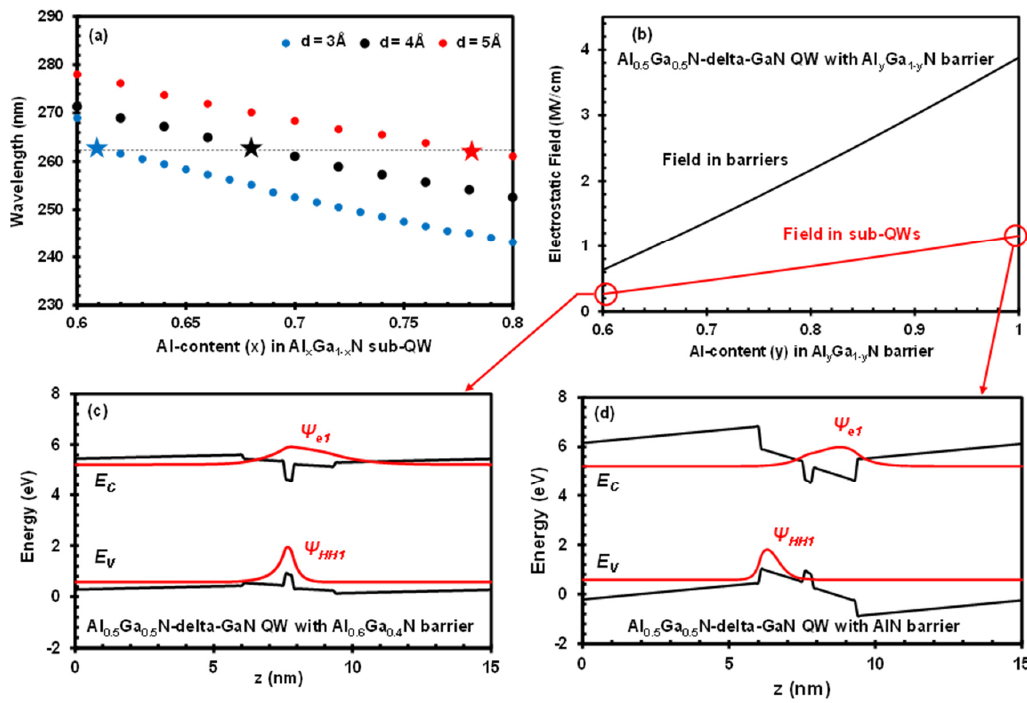
Figure 2. ( a ) Emission wavelengths from Al x Ga 1−x N-delta-GaN QW/AlN barrier with different sub-QW Al contents (x = 0.6–0.8) and delta-GaN thicknesses (d = 3–5 Å); ( b ) electrostatic fields in barriers and sub-QWs from Al 0.5 Ga 0.5 N-delta-GaN QWs with d = 3 Å. Band structure and wave function of Al 0.5 Ga 0.5 N-delta-GaN QW with ( c ) the Al 0.6 Ga 0.4 N barrier and ( d ) the AlN barrier .